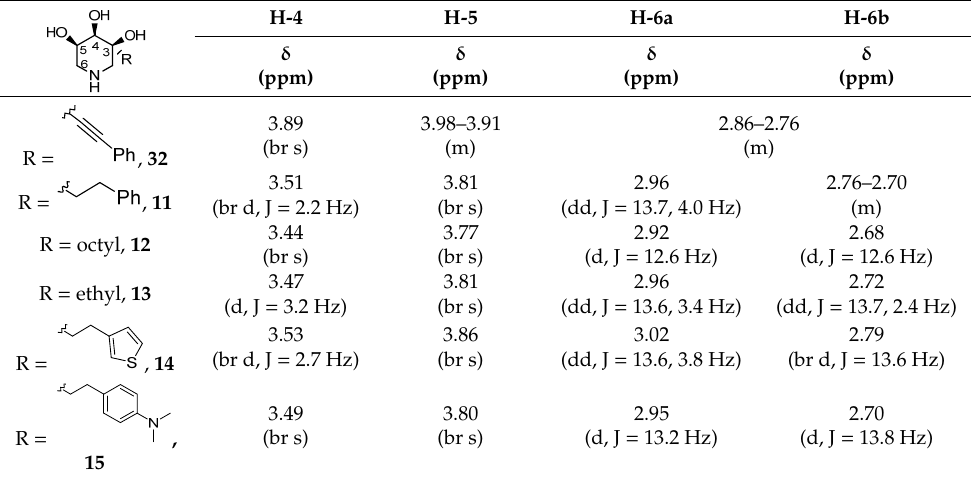
Table 3. Chemical shifts and coupling constants of H-4, H-5, and H-6 of protected compounds 32 and 11 – 15 , in CD 3 OD.